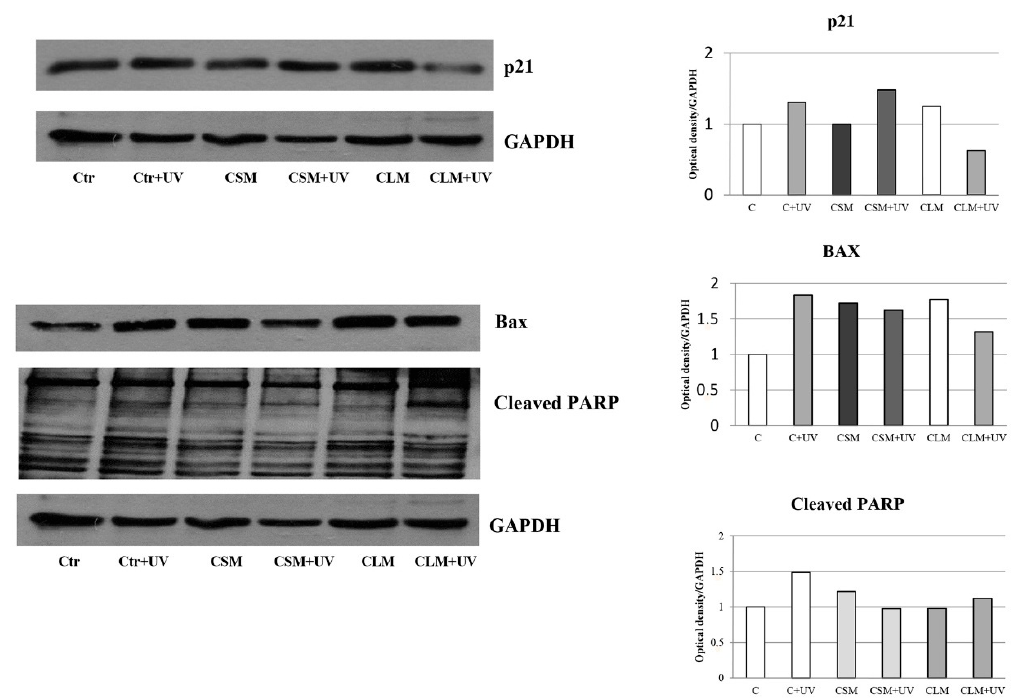
Figure 5. Western Blot analysis of p21, BAX, and PARP (poly ADP-ribose polymerase) protein levels in C32 cells treated or not with CSM and CLM extracts for 24 h, both in the presence and absence of UV. The histograms refer to the densitometric analysis (OD) of the Western blot shown in the figure.